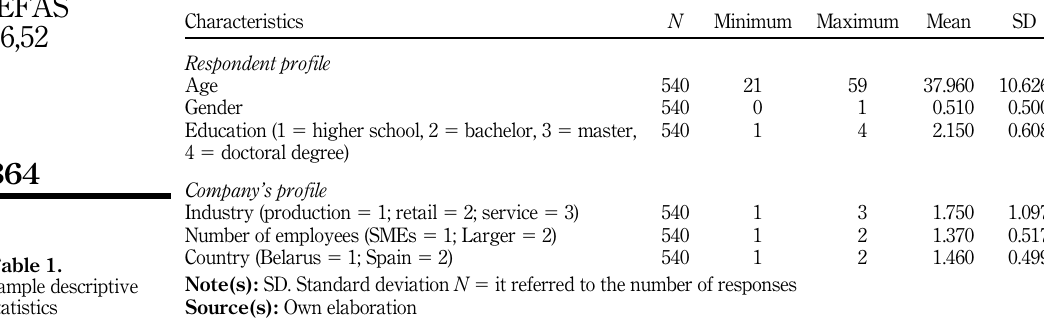
Table 1. Sample descriptive statistics